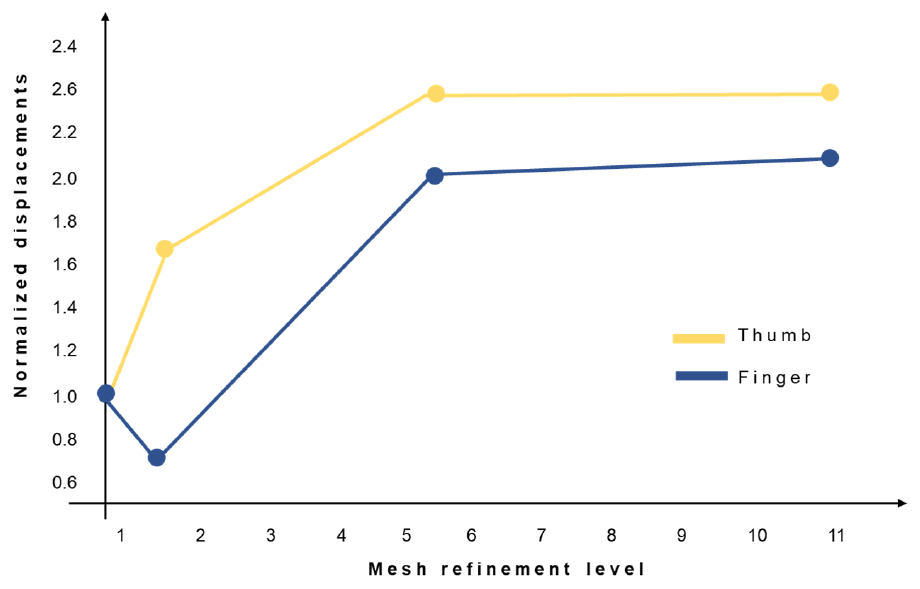
Figure 3. Mesh refinement process for both the obsolete finger (in blue) and thumb (in yellow).